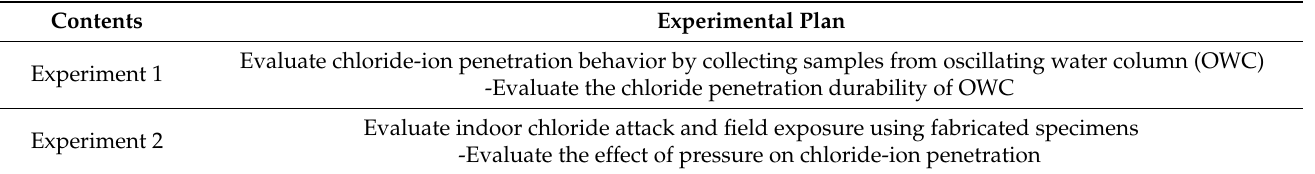
Table 1. Design of experiments.